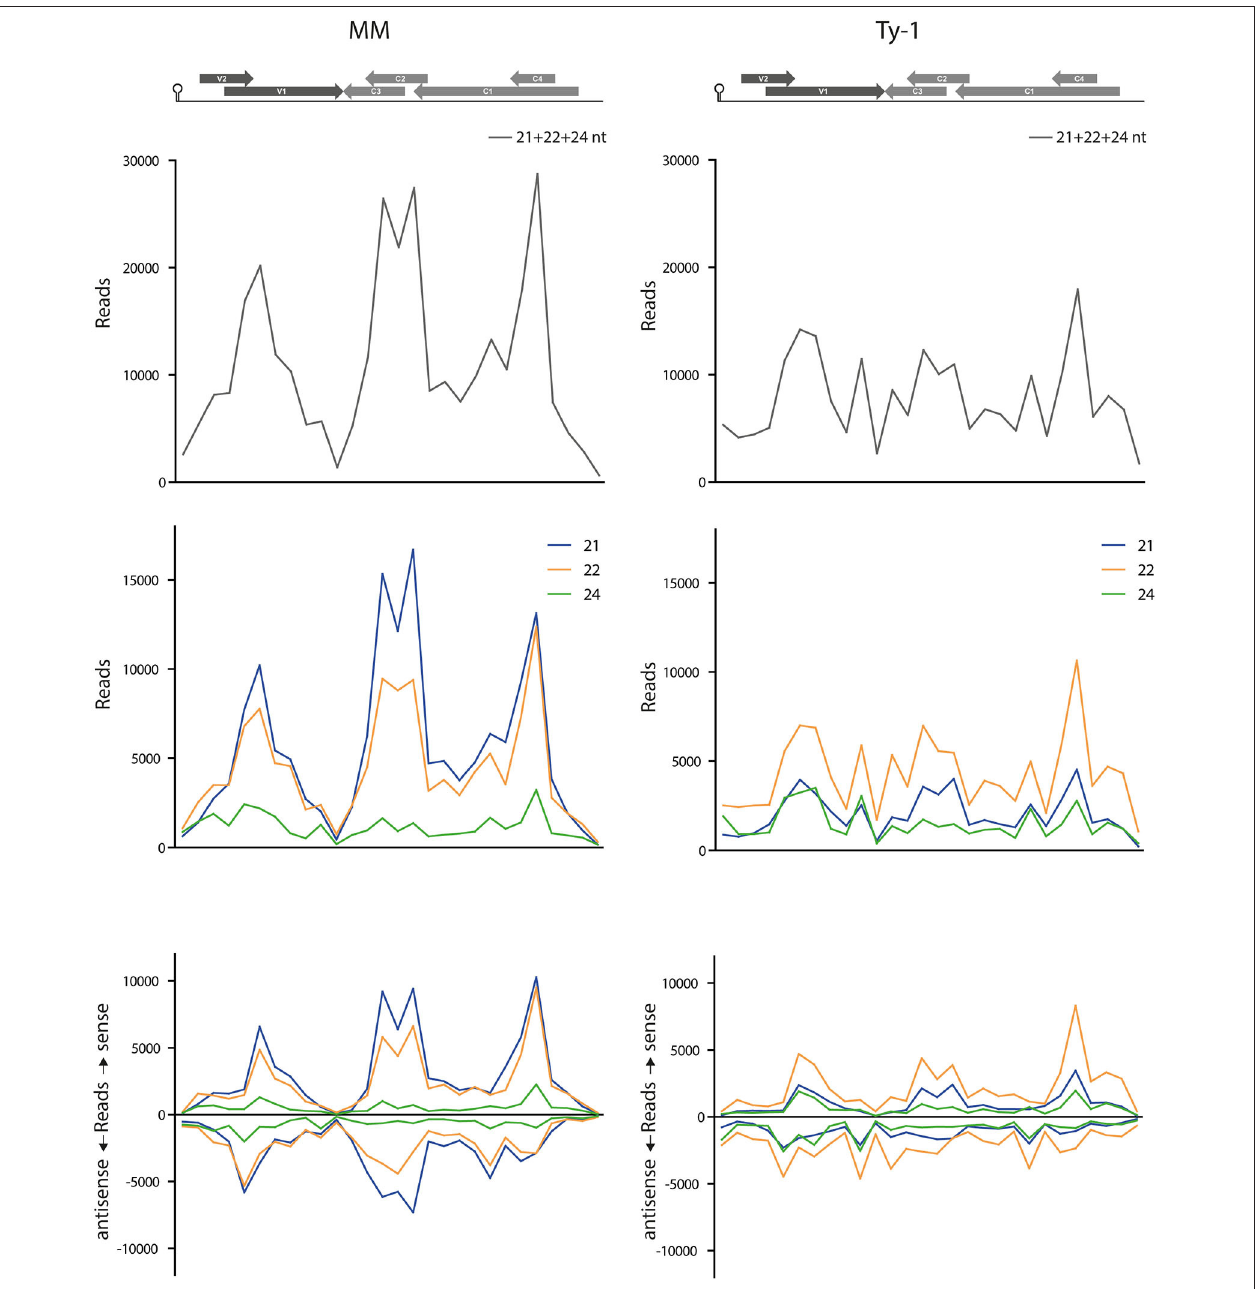
FIGURE 6 | Amount of vsiRNA reads per 100 nucleotides in the TYLCV genome. Viral siRNAs isolated from infected MM (left panel) or Ty-1 bearing (right panel) tomato are mapped on the genome of tomato yellow leaf curl virus (TYLCV). The numbers of reads per 100 nucleotides of the TYLCV genome (amount of reads for position 1–100, 101–200, etc.) are plotted. The graphs represent the average of three biological replicates. The upper panels present the amount of reads of 21-, 22-, and 24-nt size class together. The middle and lower panels depict the distribution of 21-, 22-, and 24-nt vsiRNA separately, either sense and antisense polarities taken together (middle panel), or both polarities specified (lower panel). A schematic overview of the TYLCV genome is presented at the top of the graph, with the viral ORFs indicated as gray arrows and the intergenic region at the left and right side.